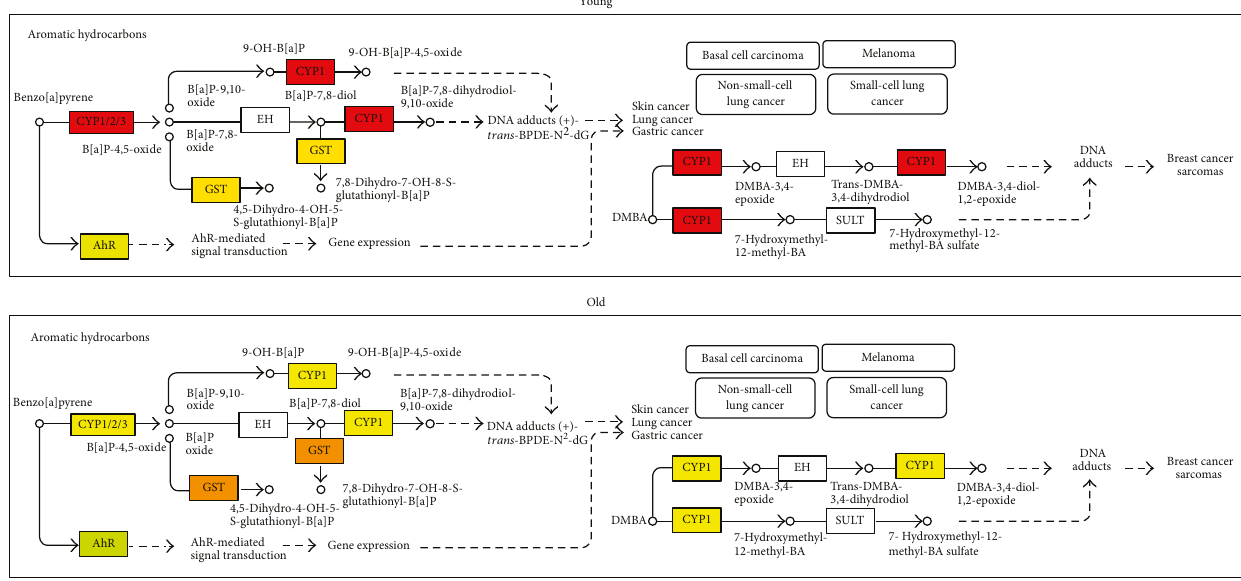
Figure 3: Aromatic hydrocarbon pathway and related signi fi cant changes observed in response to postprandial serum (red: strongly upregulated compared to fasting serum; orange: mildly upregulated compared to fasting serum; green: downregulated compared to fasting